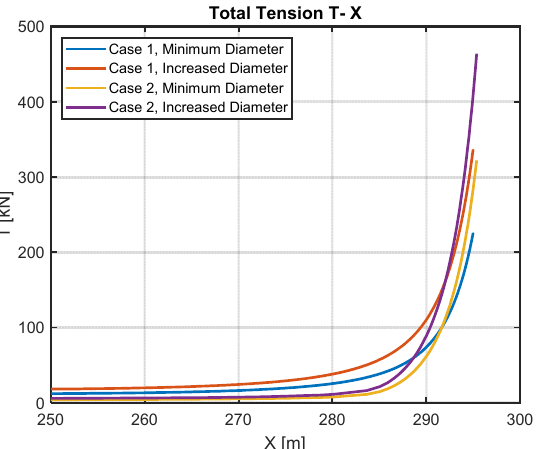
Figure 12. Total mooring tension at the fairlead as a function of horizontal distance from the anchor to the buoy.